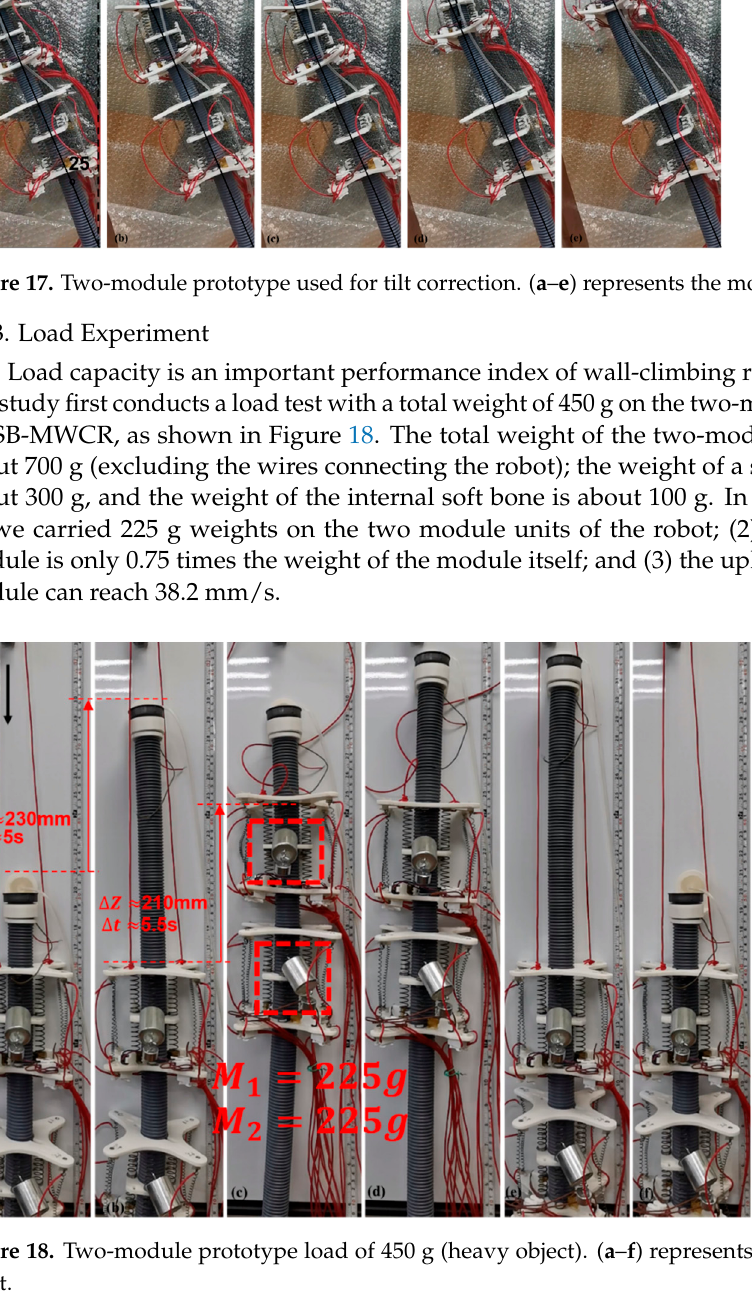
Figure 19. Maximum payload test of single module prototype. ( a – g ) represents the motion of the robot. 3.3.4. Spanning Experiment with Discontinuous Surface To test the adaptability of the ISB-MWCR to discontinuous walls, a discontinuous wall with adjustable spacing was designed in this study, as shown in Figure 20. The robot completed the crossing challenge of 150-mm spacing, which is about 1.37 times the length